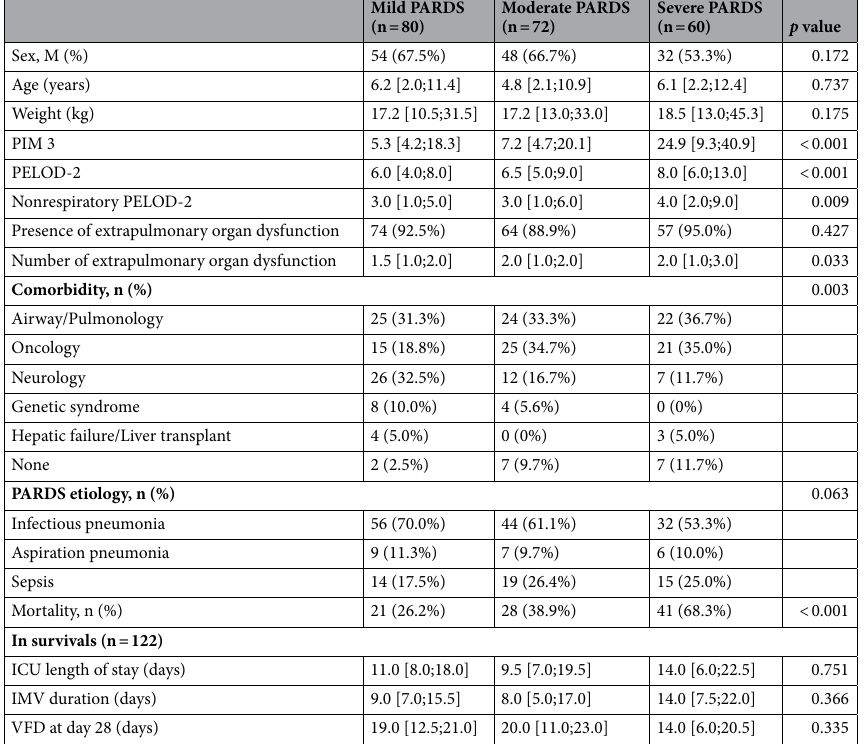
3, PELOD-2 Pediatric logistic organ dysfunction-2 score, ICU Intensive care unit, IMV Invasive mechanical ventilation, VFD Ventilator-free